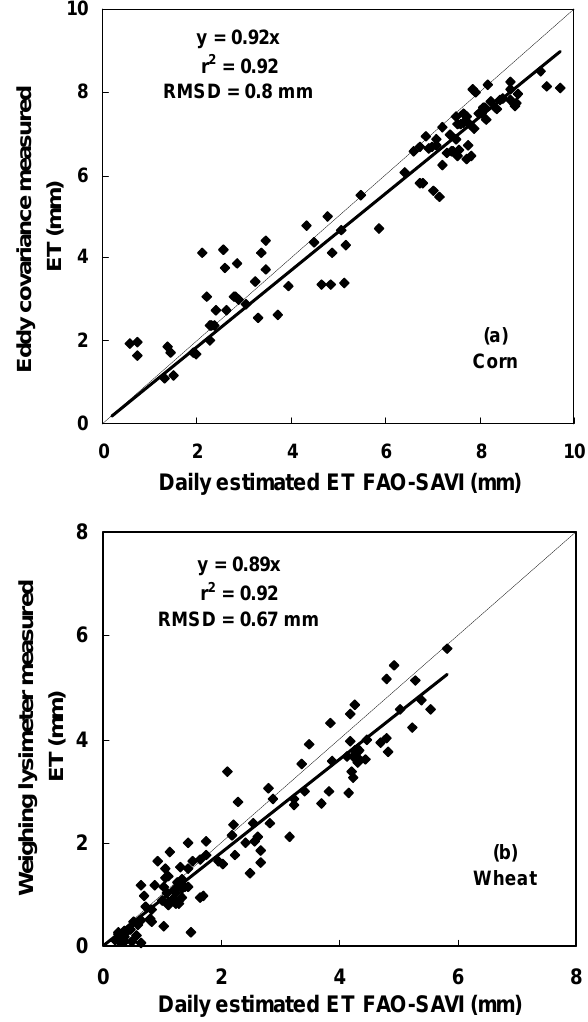
Fig. 3. Daily measured and estimated ET for corn (2008) (a) and Fig.3 Daily measured and estimated ET for corn (2008) (a) and wheat 25 wheat (2009) (b) using a radiometer-estimated K cb . The thin solid (2009) (b) using a radiometer-estimated K cb . The thin solid diagonal line 26 diagonal line represents the 1:1 line, while the dark line segment represents the linear regression through the represents the 1:1 line, while the dark line segment represents the linear 27 regression through the points. 28